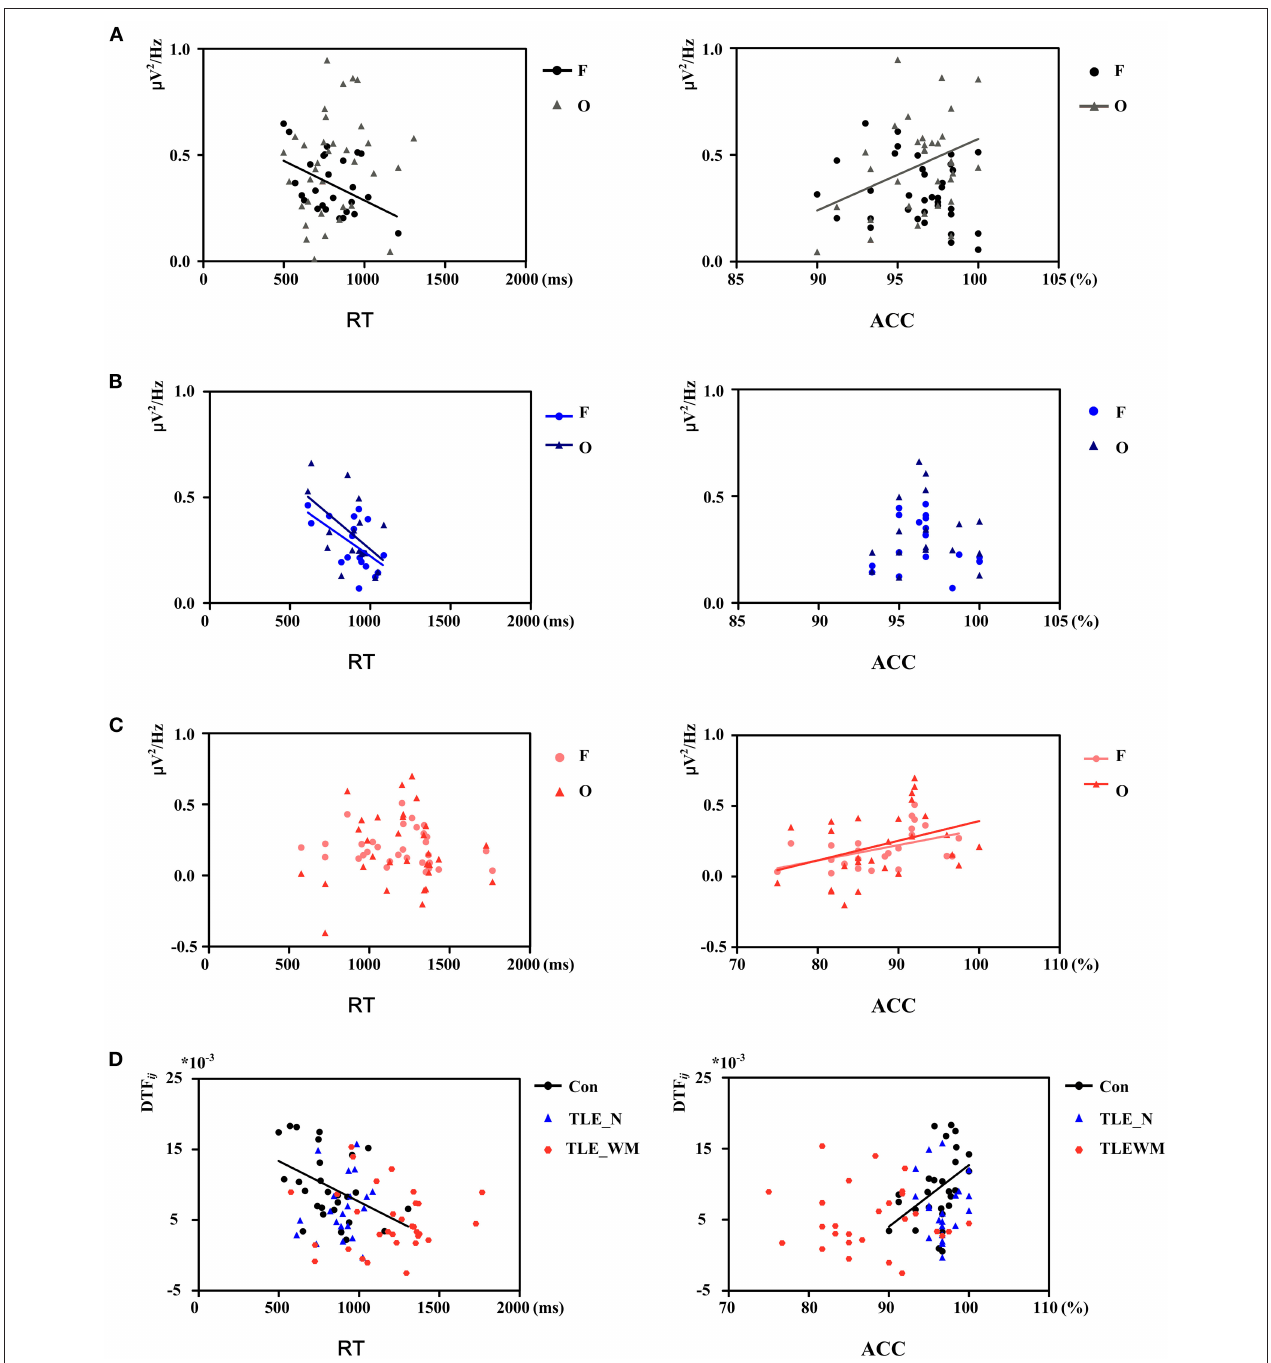
FIGURE 8 | Correlation between theta network activity and performance on the WM task. Correlation between theta P wm values in different brain regions and performance in the Con group (A) , TLE-N group (B) , and TLE-WM group (C) . (D) Correlation between theta DTF values and performance.